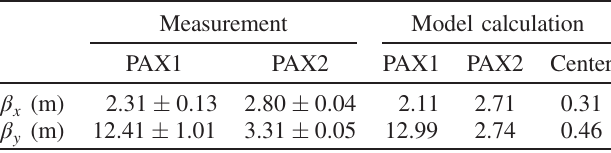
TABLE III. Measured and calculated betatron functions β β from the MAD model at the position of the PAX quadrupole y magnets (outer pair: PAX1; inner pair: PAX2). The calculated β -functions at the target center are given in column